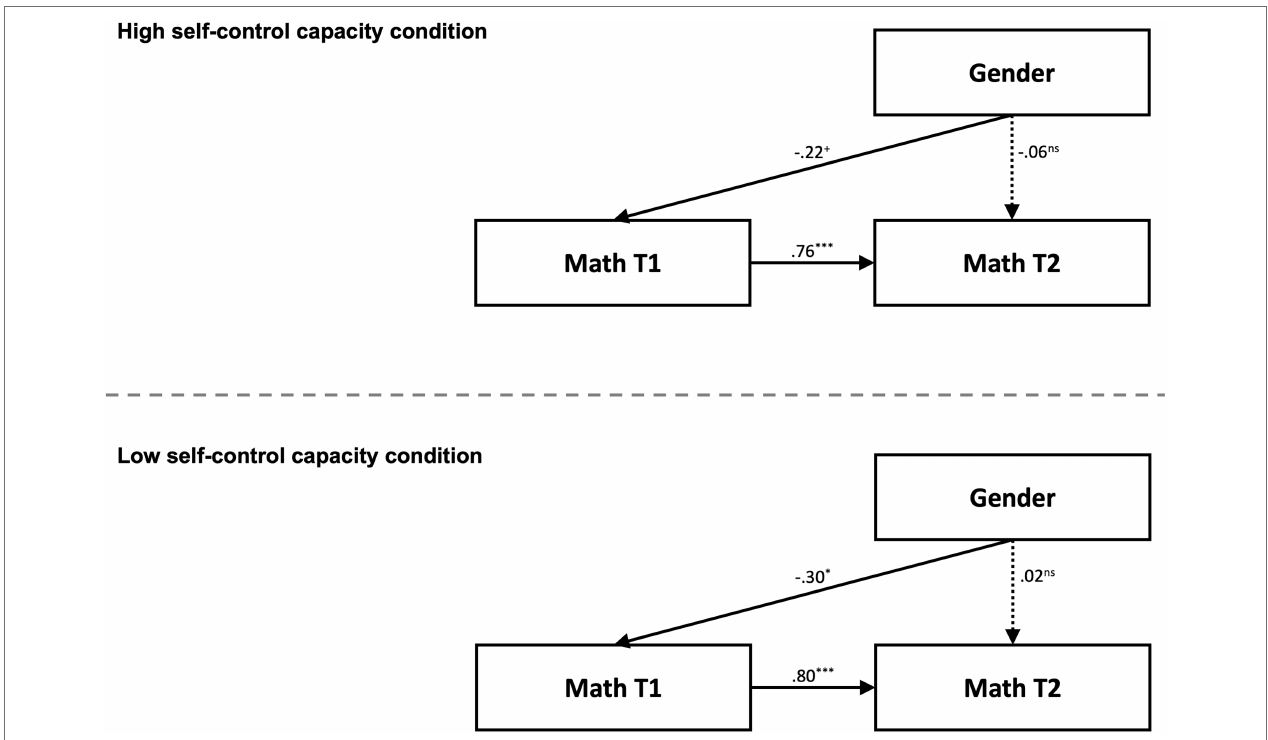
FIGURE 2 | Multiple-group autoregressive path model including gender as a covariate. Top: High self-control capacity condition. Bottom: Low self-control capacity condition. Coding of gender: 0 = male, 1 = female. T1/T2 = first/second measurement times. Presented are standardized path coefficients. Dotted lines differ significantly between the two conditions. N = 102. *** p < 0.001, ** p < 0.01, * p < 0.05, + p < 0.10, ns =